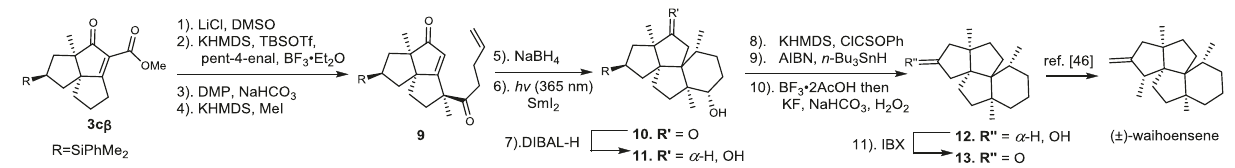
Fig. 4 Synthesis of (±)-Waihoensene. Reagents and conditions: 1). LiCl (3.0 equiv), H 2 O (30.0 equiv), DMSO, 180 °C, 1 h, 89%; 2). KHMDS (1.5 equiv), TBSOTf (1.5 equiv), THF, 0 °C, 40 min, then Pent-4-enal (1.2 equiv), BF 3 ·Et 2 O (1.0 equiv), DCM, − 78 °C, 1 h; 3). NaHCO 3 (2.0 equiv), DMP (1.5 equiv), DCM, 0 °C, 1 h; 4). KHMDS (1.5 equiv), MeI (10.0 equiv), THF, − 78 °C to rt, 1 h, 35% for three steps; 5). NaBH 4 (1.5 equiv), − 78 °C, 8 h, 70%; 6). hv (365 nm), MeCN, rt, 2 h and then SmI 2 (30.0 equiv), t -BuOH (4.0 equiv), HMPA (20.0 equiv), THF, rt, 8 h, 40% for 10 and 13% for 11 ; 7). DIBAL-H (6.0 equiv), DCM, − 78 °C, 1 h, 85%; 8). KHMDS (4.0 equiv), ClCSOPh (4.0 equiv), THF, − 78 °C, 1 h; 9). AIBN (0.4 equiv) and n -Bu 3 SnH (5.0 equiv),